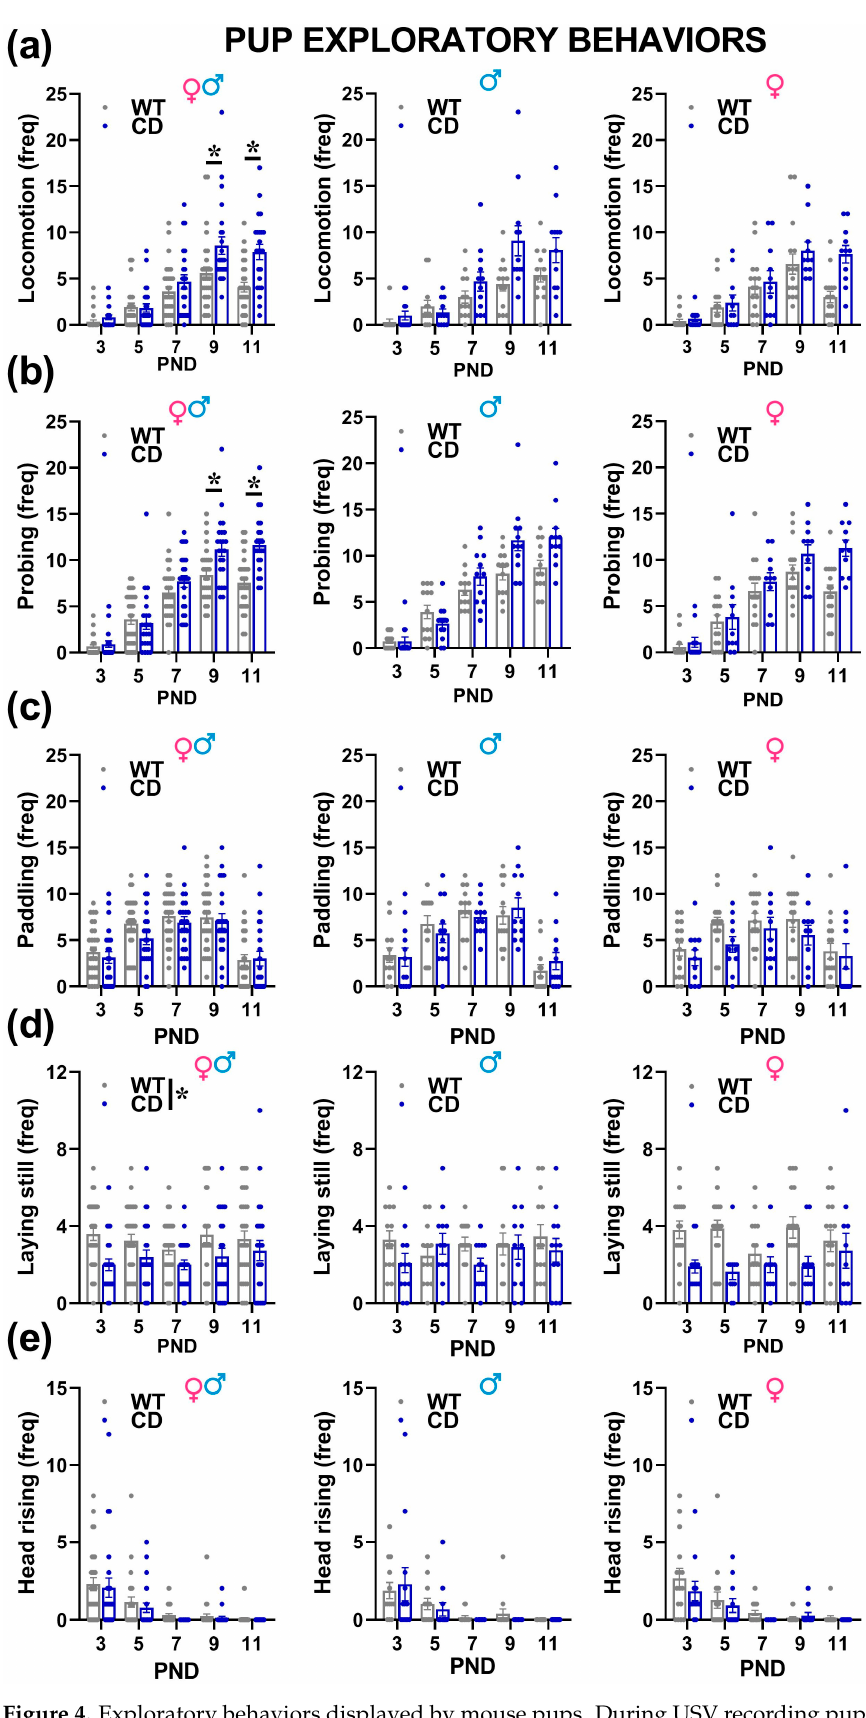
Figure 4. Exploratory behaviors displayed by mouse pups. During USV recording pups’ behaviors were assessed by the analysis of video files and their frequency was scored. The following behav- iors were mostly displayed on all PNDs: locomotion ( a ); body displacement of at least 1 cm in the